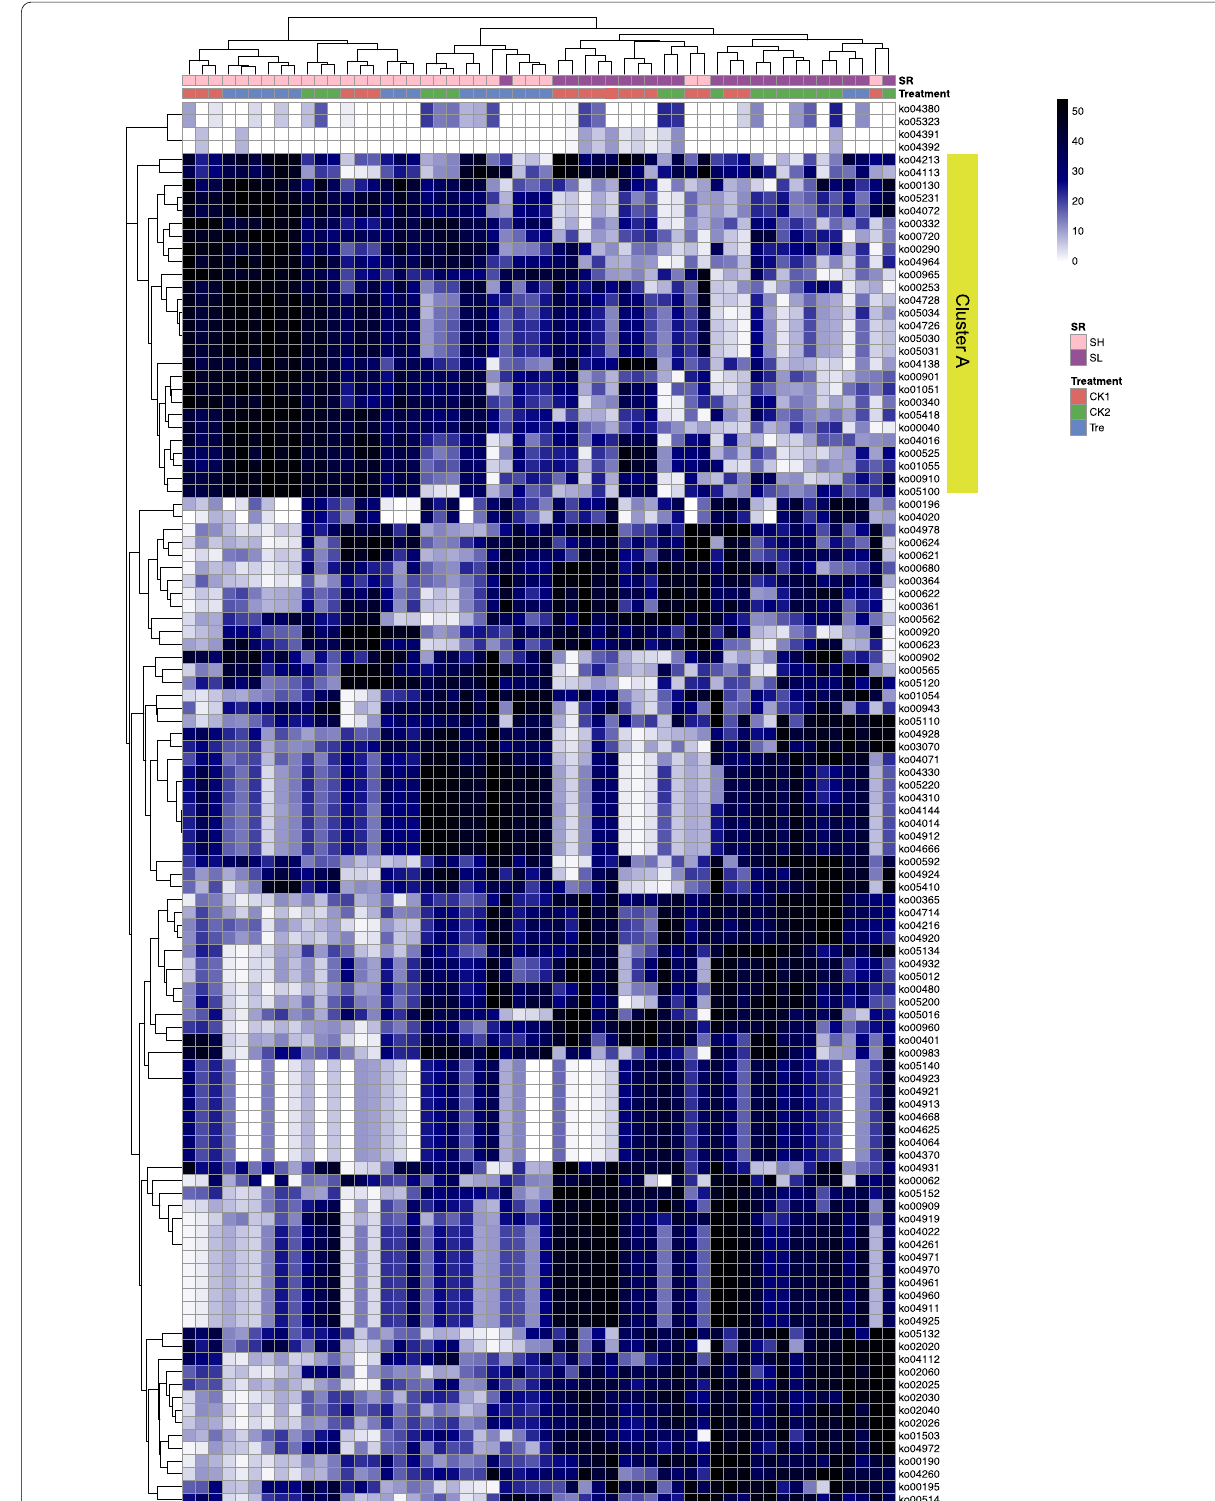
Fig. 5 Heatmap of differentially abundant Kos and the relative abundance of Ko was normalized by